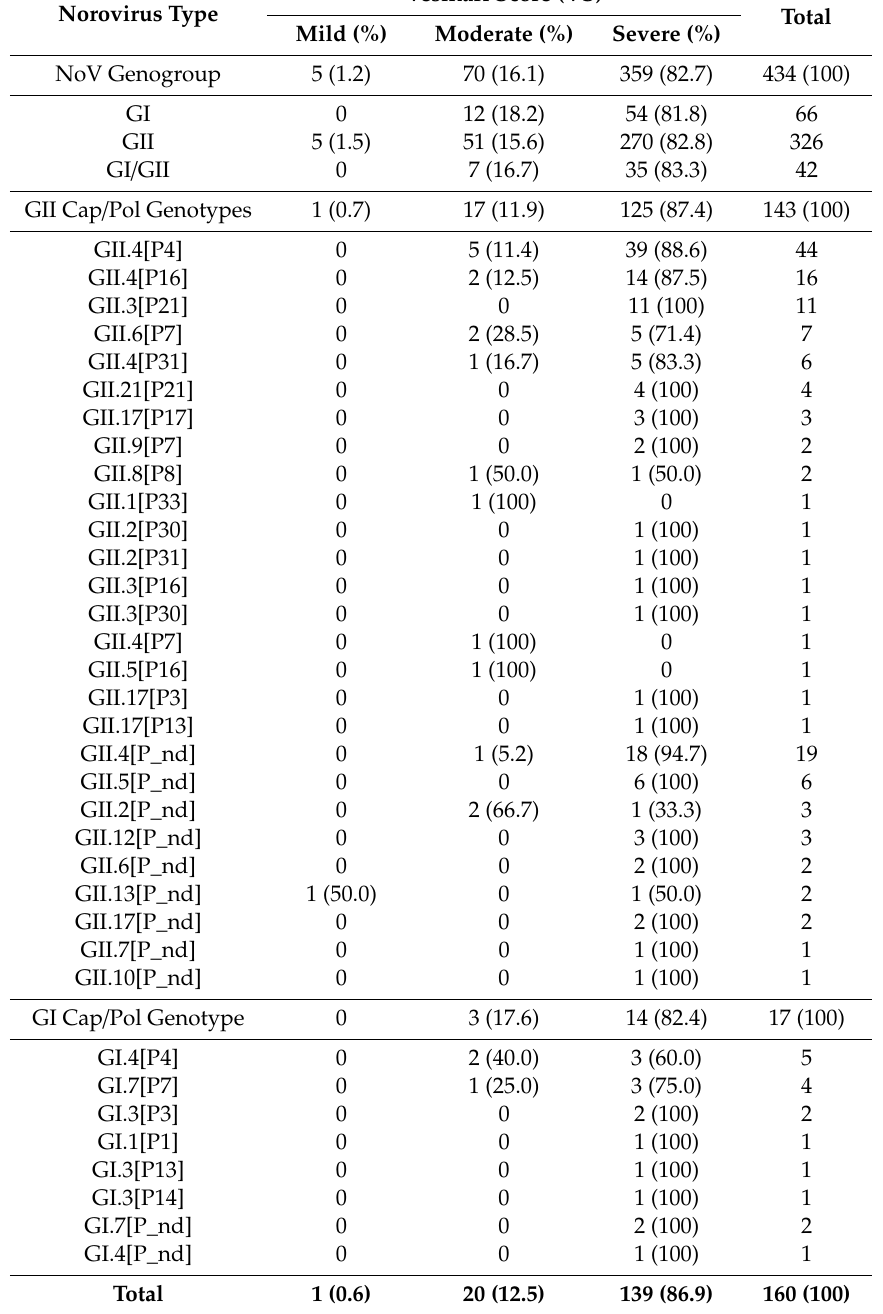
Table 2. Association between NoV genogroups and genotypes and clinical severity of norovirus infections in children as measured with the Vesikari scoring